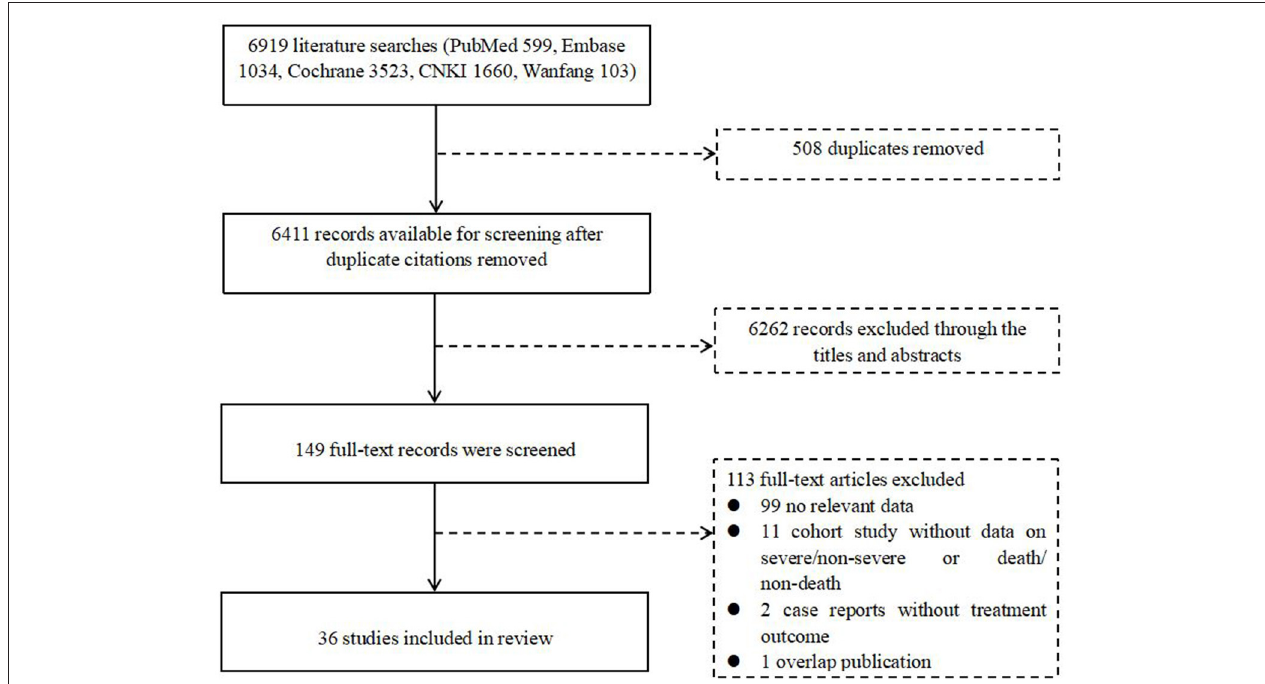
FIGURE 1 | Flow diagram for the inclusion of studies. CNKI, Chinese National Knowledge